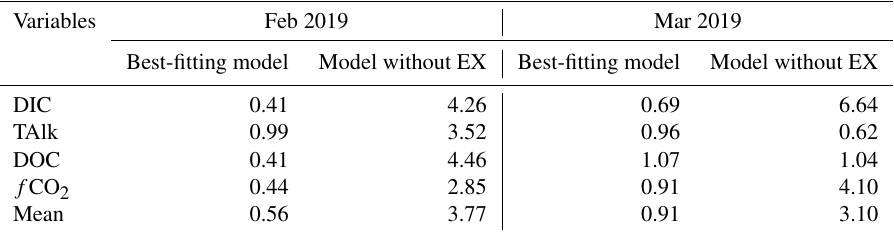
Figure 5. Biomass and coverage of macroalgae along transect line 1 (a, b) and line 2 (c, d) in March 2019. Grey and white shading indicate Sargassum algae and other macroalgae, respectively. Black arrows indicate sampling locations for macroalgal biomass. Table 2. Root-mean-square errors (RMSEs) for best-fitting models and models assuming that water exchange rate (EX) was zero. RMSEs were calculated for the z scores of DIC, TAlk, DOC, and f CO 2 values, which were differences from the mean observed values divided by the standard deviations. The best-fitting model that minimized the averaged RMSEs for these four parameters was determined for each